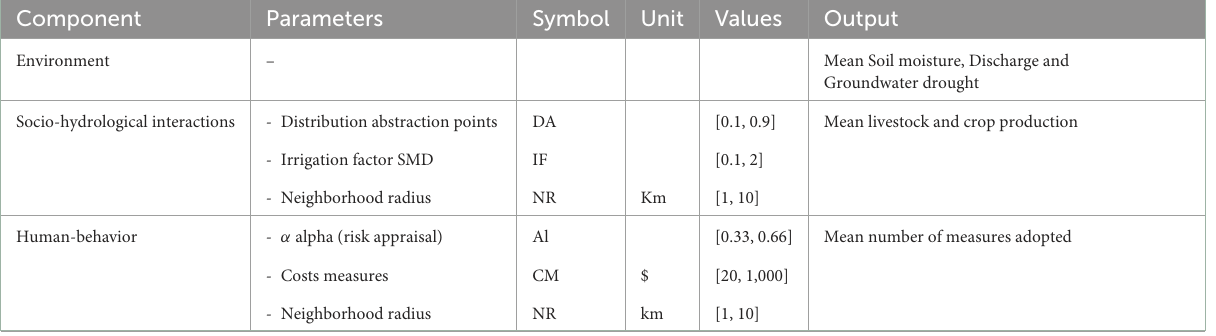
TABLE 3 Parameters and output variables in global sensitivity